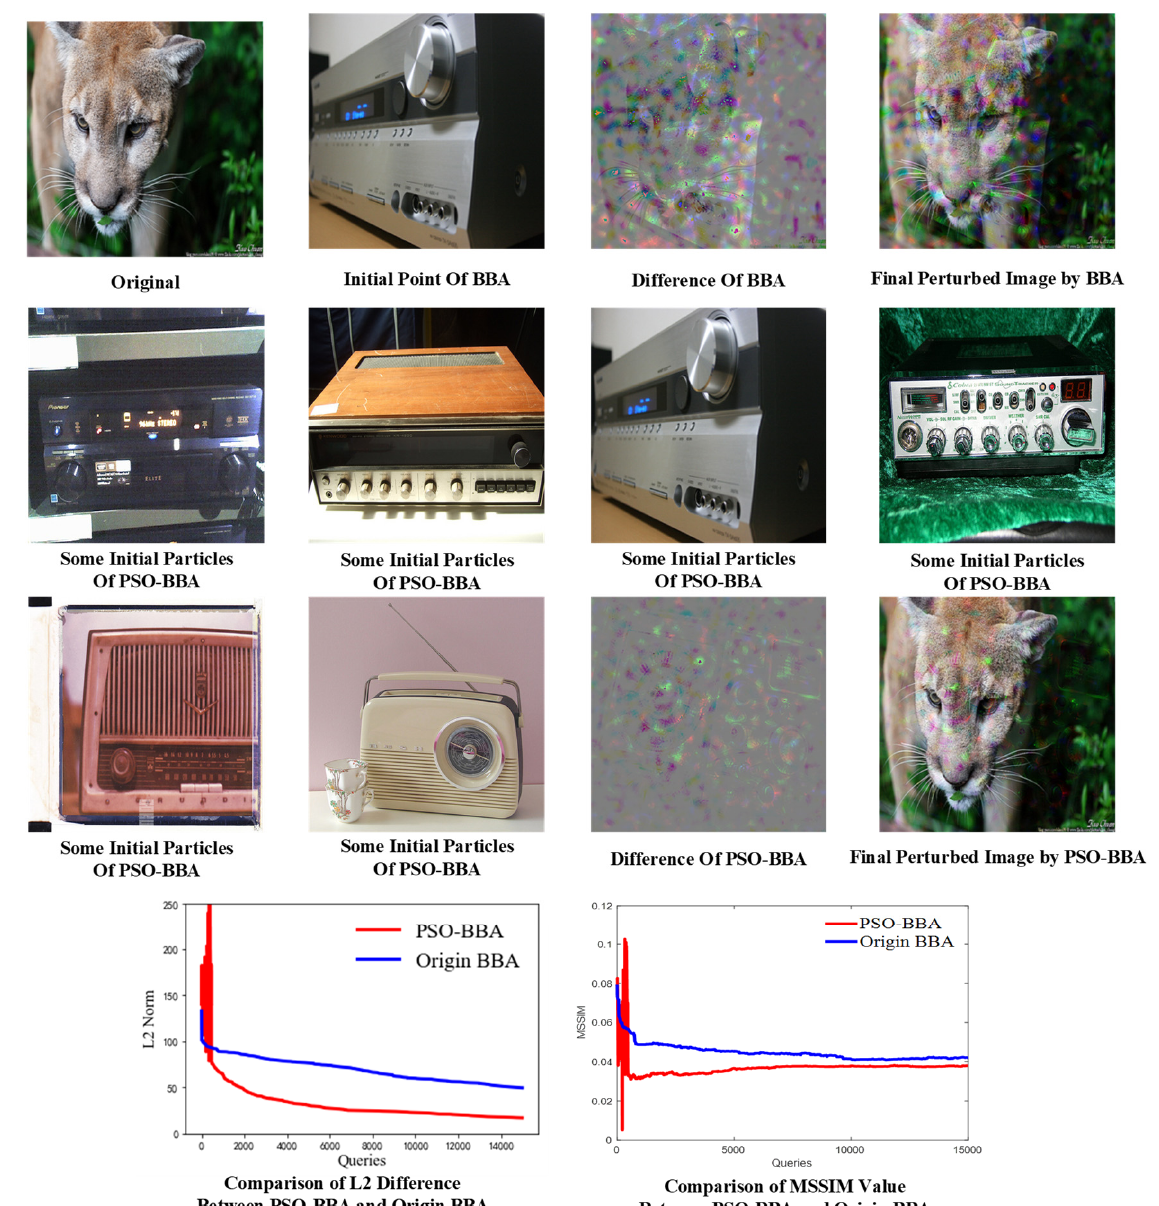
Figure 8. Comparison Experiment 2 of specific adversarial process and results between PSO-BBA and BBA.